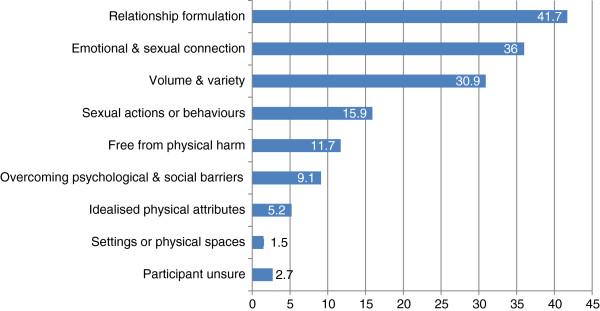
Proportion of responses including each theme (not mutually exclusive).